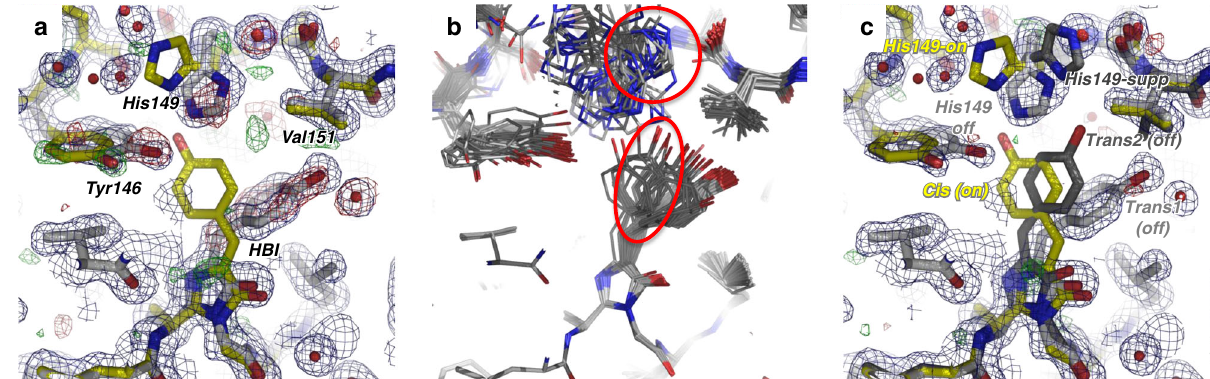
Fig. 3 Off-state structure. Chromophore (HBI) and its neighboring residues in the rsEGFP2 laser_off structure determined by SFX without pump-laser activation are shown. a The initial laser-off model consists of a mixture of the off-state conformer (light gray carbon trace) and the residual on-state conformer (yellow carbon trace) with occupancies of 90% and 10%, respectively. 2F obs laser_off – F calc laser_off (blue) and F obs laser_off – F calc laser_off (green/red) maps at 1.6 Å resolution are displayed at 1 σ and ±3 σ , respectively. A positive F obs laser_off – F calc laser_off peak between the trans (gray) and the cis (yellow) chromophores suggests the presence of an additional conformer. b Result of ensemble re fi nements against the laser_off dataset starting for the off-state model (chromophore 100 % trans1 ). A third chromophore conformation and a third rotamer of His149 are revealed. ( c ) The fi nal laser-off model features triple conformations of His149 and of the chromophore, i.e. His149-off and trans1 (light gray), His149- on and cis (yellow) and the additional His149-supp and trans2 (dark gray) conformations, at 65%, 10% and 25% occupancy, respectively. 2F obs laser_off – F calc laser_off (blue) and F obs laser_off – F calc laser_off (green/ red) maps calculated from the laser-off dataset at 1.6 Å resolution are displayed at 1 σ and ±3 σ , respectively.